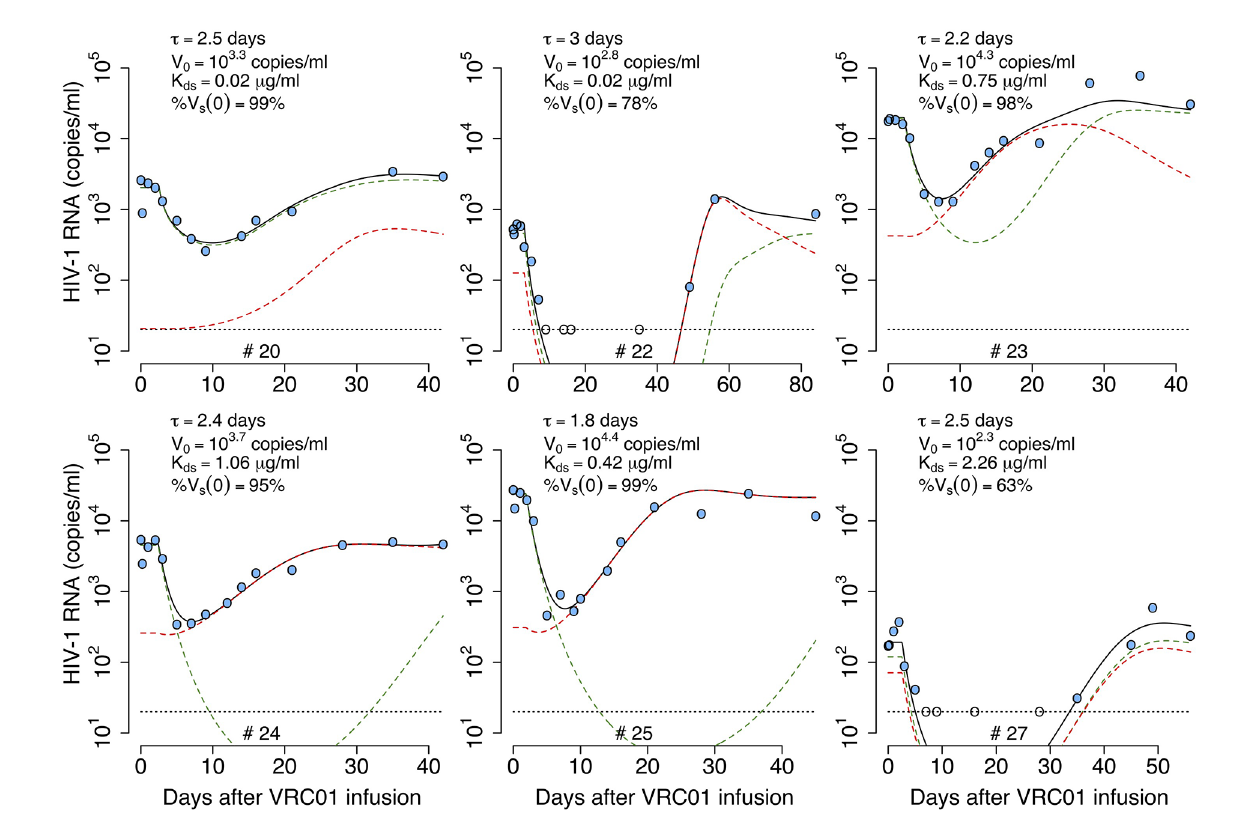
FIGURE 5 | Best- fi ts of the two viral population delayed neutralization model, equation (14), to viral load data from participants receiving a single infusion of VRC01. Blue- fi lled and un fi lled circles are the HIV-RNA over and below the limit of detection, respectively. Solid black lines are the best- fi t of the model to the data ( V s + V r ). Green and red dashed lines show the sensitive ( V s ) and less sensitive ( V r ) virus concentration prediction of the model, respectively. Fixed parameter values are described in Table 1 . See all parameter estimates in Table S3 . Other parameters and initial values were derived by assuming the system was in steady state before VRC01